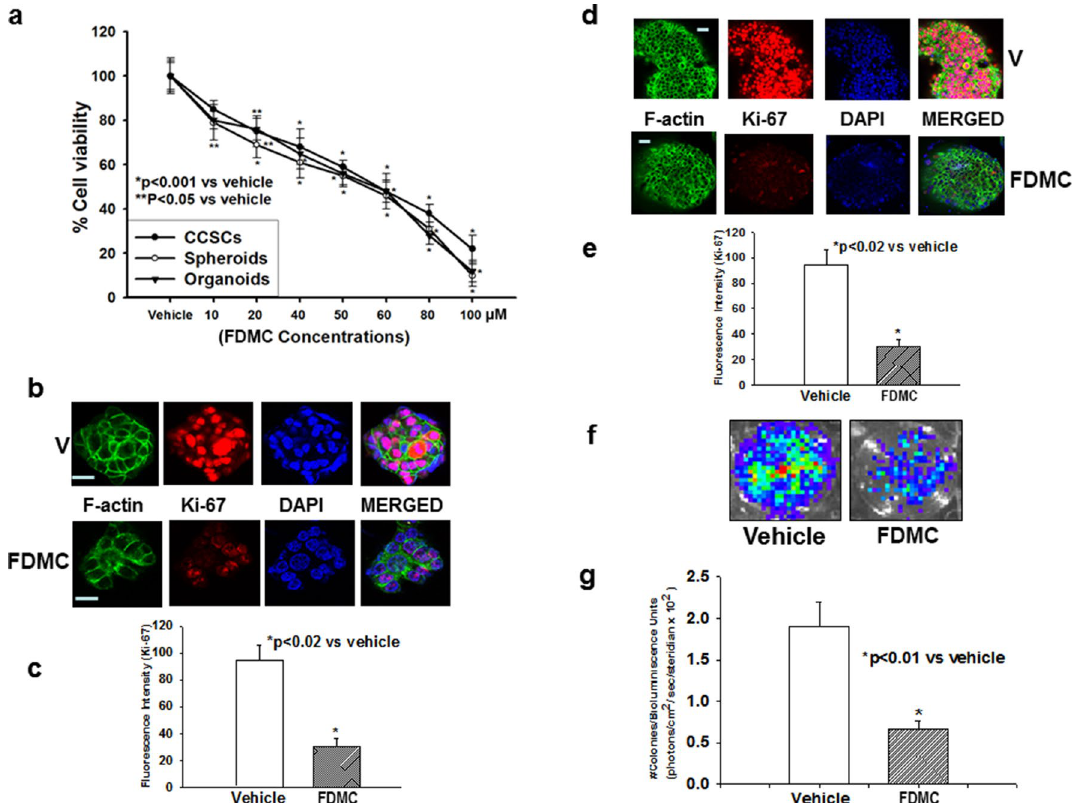
Figure 1. Effects of FDMC on growth of human colon cancer stem cells (CD24 + , CD44 + , LGR5 + ), spheroids, and organoids, as evidenced by comparisons with vehicle-treated controls (V = vehicle). ( a ) FDMC significantly inhibited cell viability of human CCSCs, spheroids, and organoids in a concentration-dependent manner (CellTiter Glo assay). ( b , c ) Confocal microscopy data show that FDMC (50 µM) significantly inhibited proliferation (Ki-67 red immunofluorescence staining) in spheroids (* p < 0.02). ( d , e ) Confocal microscopy data show that FDMC (50 µM) significantly inhibited proliferation (Ki-67 red immunofluorescence staining) in organoids (* p < 0.02). ( f , g ) Colonogenic soft agar assay with luciferase-expressing CCSCs shows that FDMC (50 µM) significantly inhibited anchorage-independent growth (luminescence units) (* p < 0.01). Results are mean ± standard error of the means (bars; n =